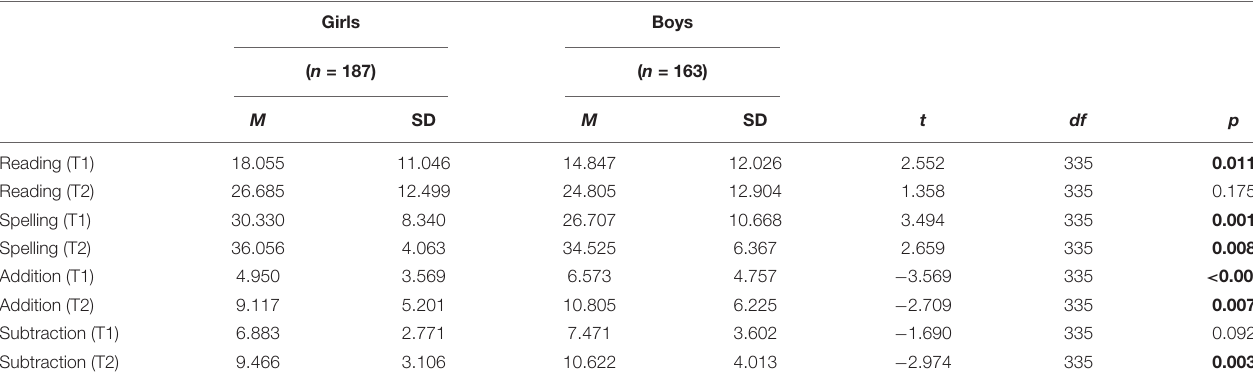
TABLE 8 | Gender differences in children’s